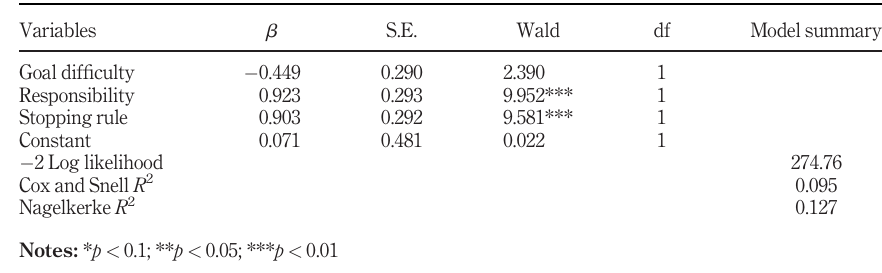
Figure 2. Percentage of decision-makers who chose to continue the project (severe condition)